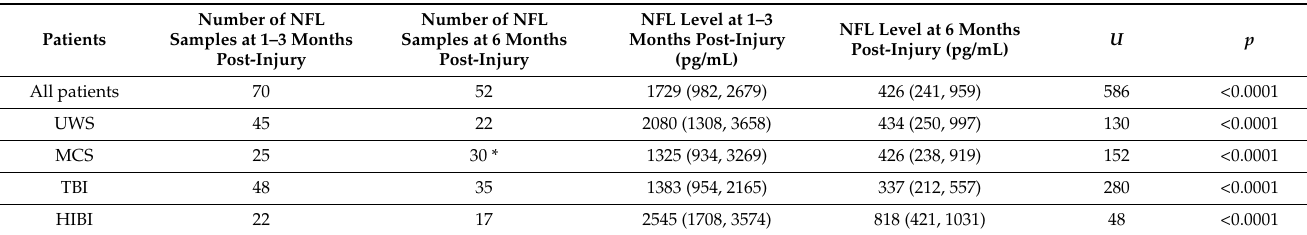
Figure 2. Distribution of NFL values in patients (at 1–3 and 6 months post-injury) and healthy controls. The horizontal lines indicate median values. One datapoint in the 1–3 months group is not reported because it fell outside of the axis limit. NFL, neurofilament light chain. Table 2. NFL levels at 1–3 and 6 months